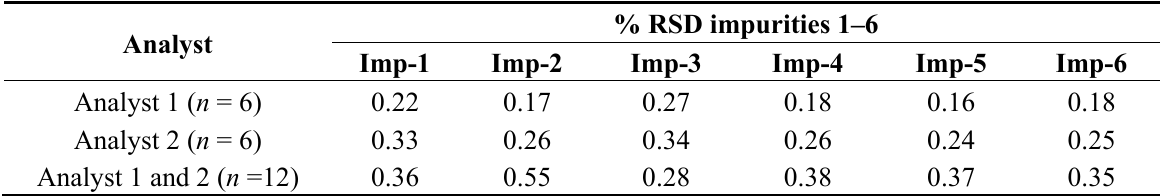
Table 2. Precision-repeatability and precision-intermediate of impurities of micafungin